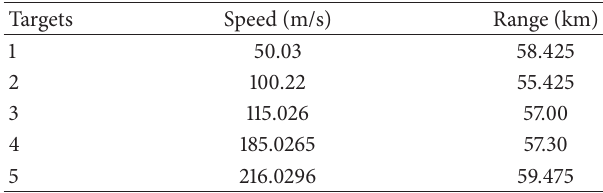
Table 2: Target position (air-to-air).